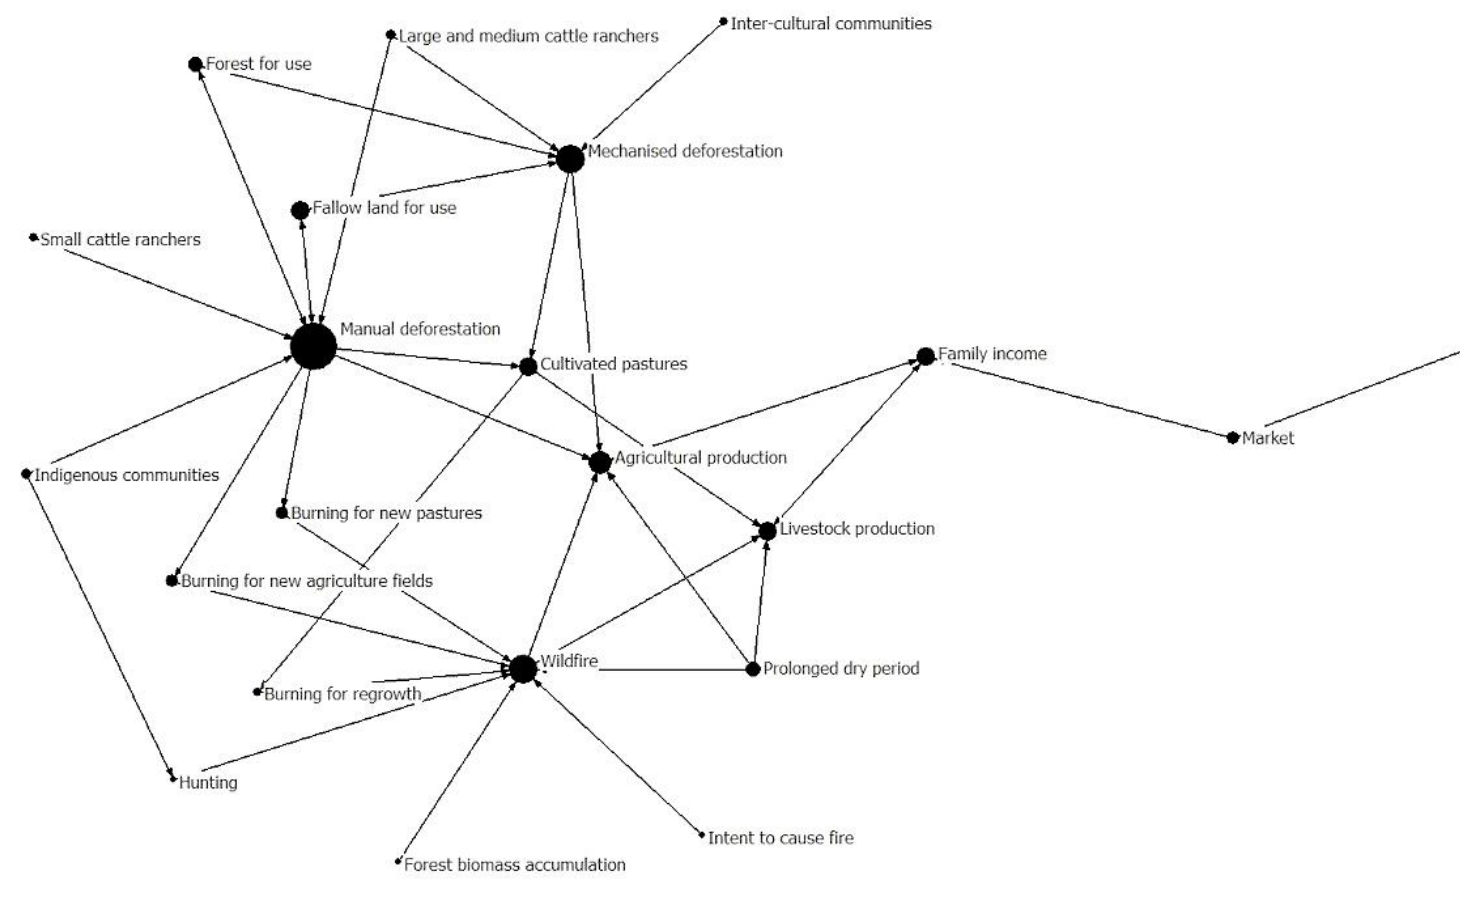
Fig. A6.4. Network showing the FCM developed in Concepción by the local communities. Variables with higher degree centrality are presented as larger nodes. Edge weights are not visualized to help